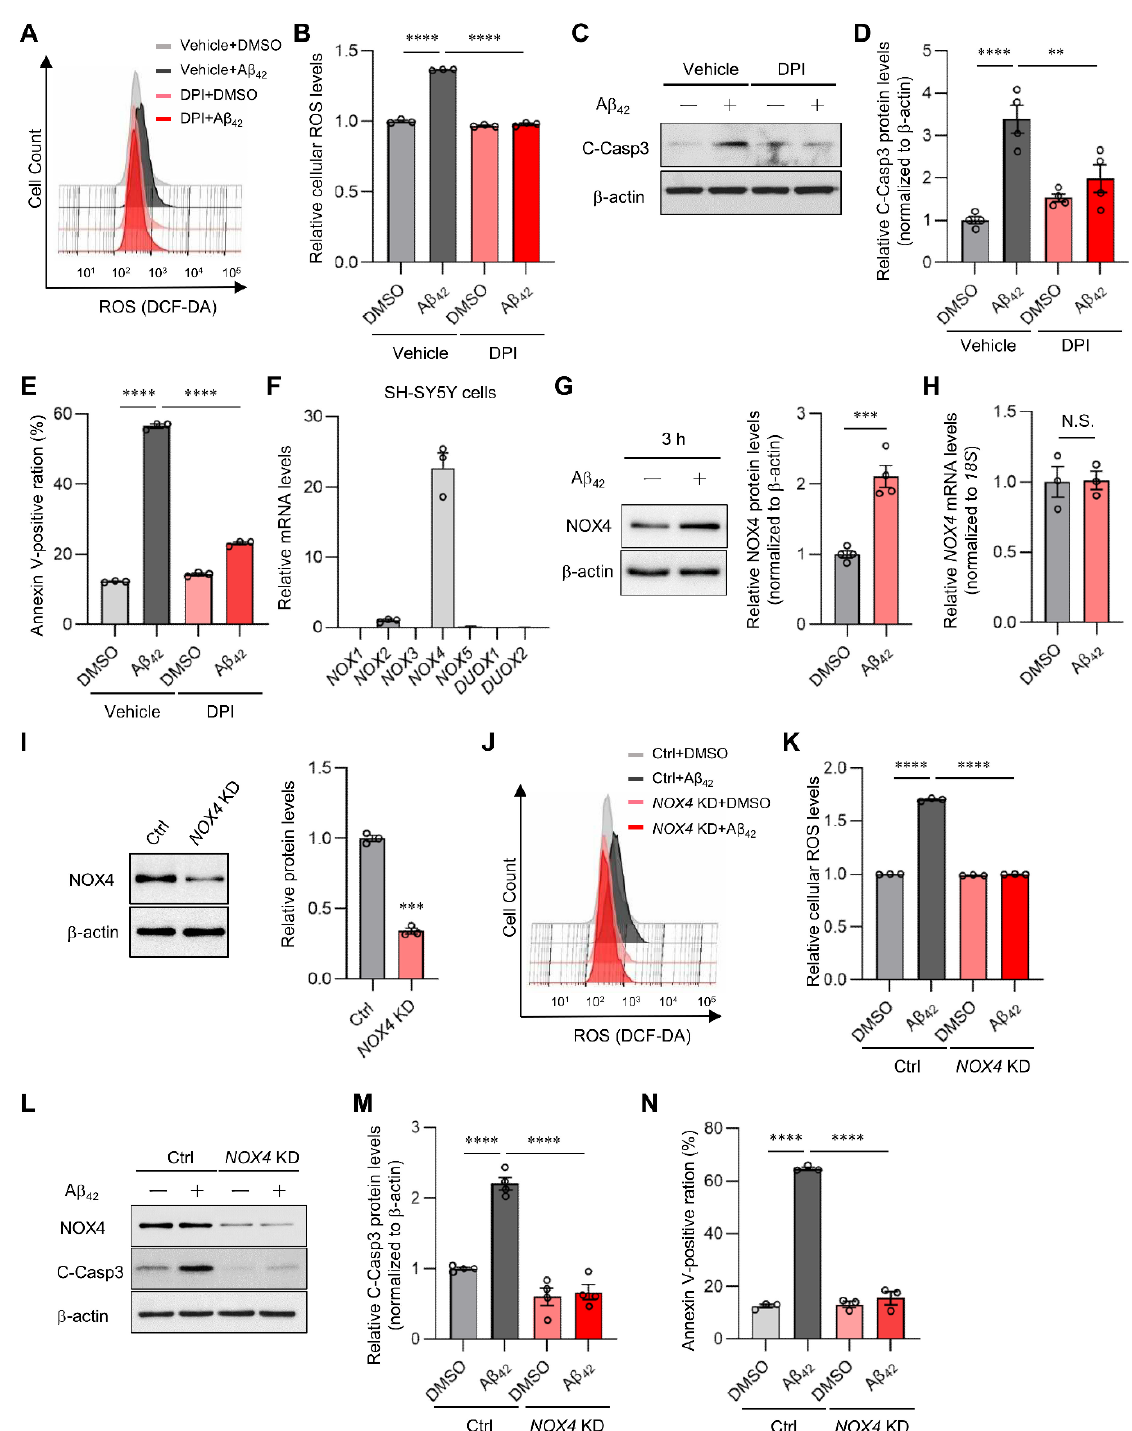
Figure 4. SIRT7 deficiency suppresses NOX-derived ROS generation. ( A ) After 0.1 μM DPI pretreatment for 1 h, SH- SY5Y cells were incubated with 5 μM Aβ 42 and 0.1 μM DPI for a further 3 h. ROS production was assessed by flow cytometry using DCF-DA. Histogram of DCF-DA intensity in a representative experiment. ( B ) The geometric mean fluorescence intensity (MFI) ± SEM of three independent experiments was analyzed. ( C ) SH-SY5Y cells were pretreated with 0.1 μM DPI and then treated with 5 μM Aβ 42 for a further 24 h in the presence of 0.1 μM DPI. Cleaved caspase 3 was examined with Western blot analysis. ( D ) The value of cleaved caspase 3 was normalized to that of β -actin. ( E ) Flow cytometry analysis was performed using annexin V-FITC/PI staining to assess apoptosis in cells treated in the same condition as in Figure 4C. The percentages of total annexin V- positive cells were calculated. ( F ) Quantitative RT-PCR analyses were conducted to examine the